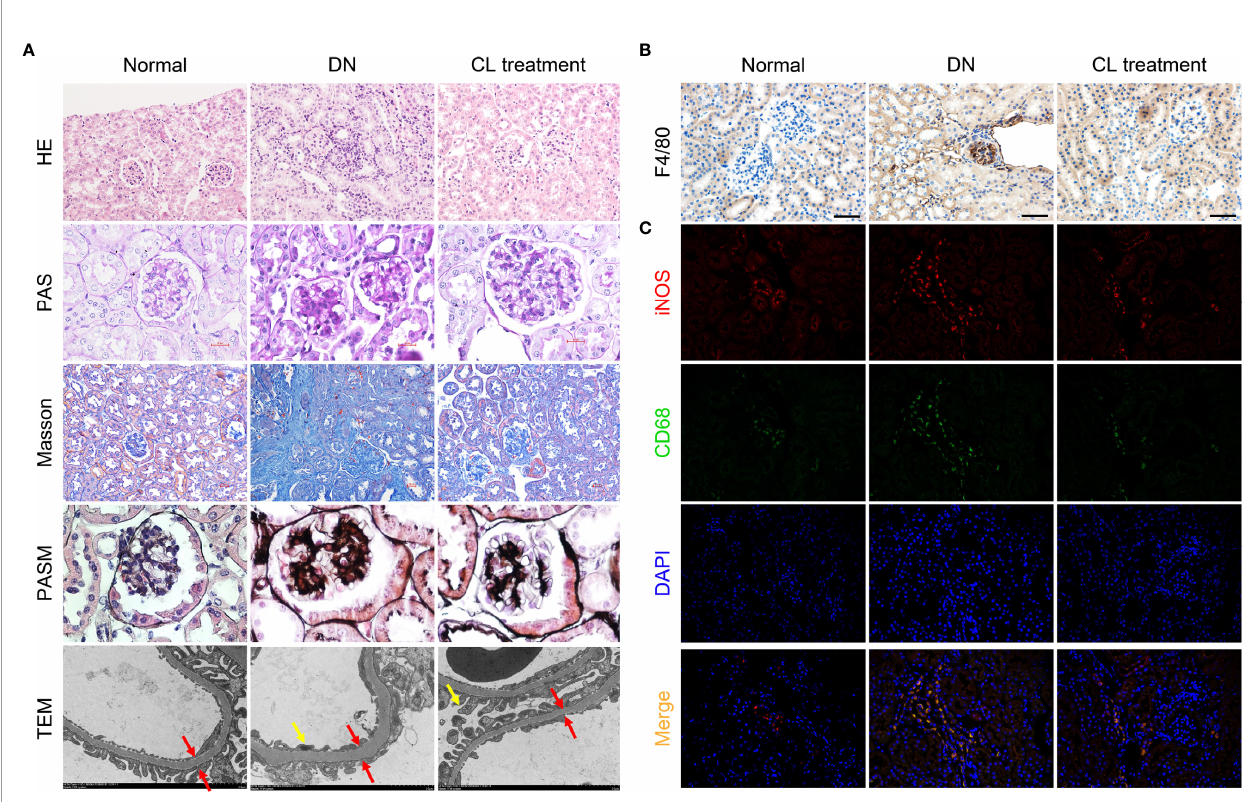
FIGURE 3 | Macrophage depletion improves kidney damages andreduces M1macrophage in fi ltration in diabetic mice. (A) Histopathologic Staining and transmission electron microscopy (TEM)of mouse kidney tissue. Hematoxylin-eosin (H-E) staining (magni fi cation:200×); periodic acid-Schiff (PAS) staining (magni fi cation:400×); Masson ’ s trichrome (Masson) staining (magni fi cation: 200×); periodic acid-silver methenamine (PASM) staining (magni fi cation:400×); transmission electron microscopy images (magni fi cation:4000×). (B) F4/80 immunohistochemicalstaining of the mouse kidney. Original magni fi cation: 200×. (C) CD68/iNOS coimmuno fl uorescence staining of mouse kidney tissue. Original magni fi cation:400×.Normal:db/m group, DN: db/db group, CLTreatment: db/db + clodronate liposome